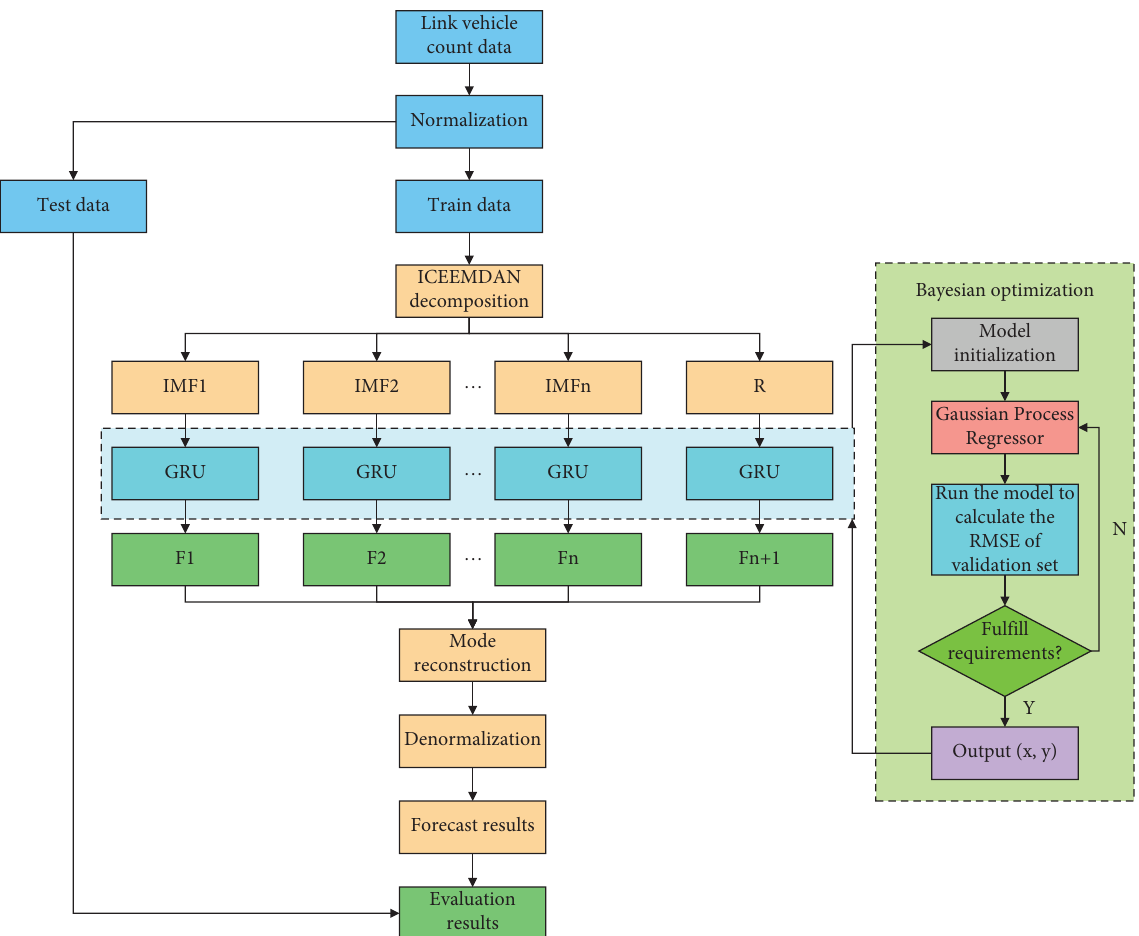
Figure 1: Framework of the link vehicle dynamic count forecasting